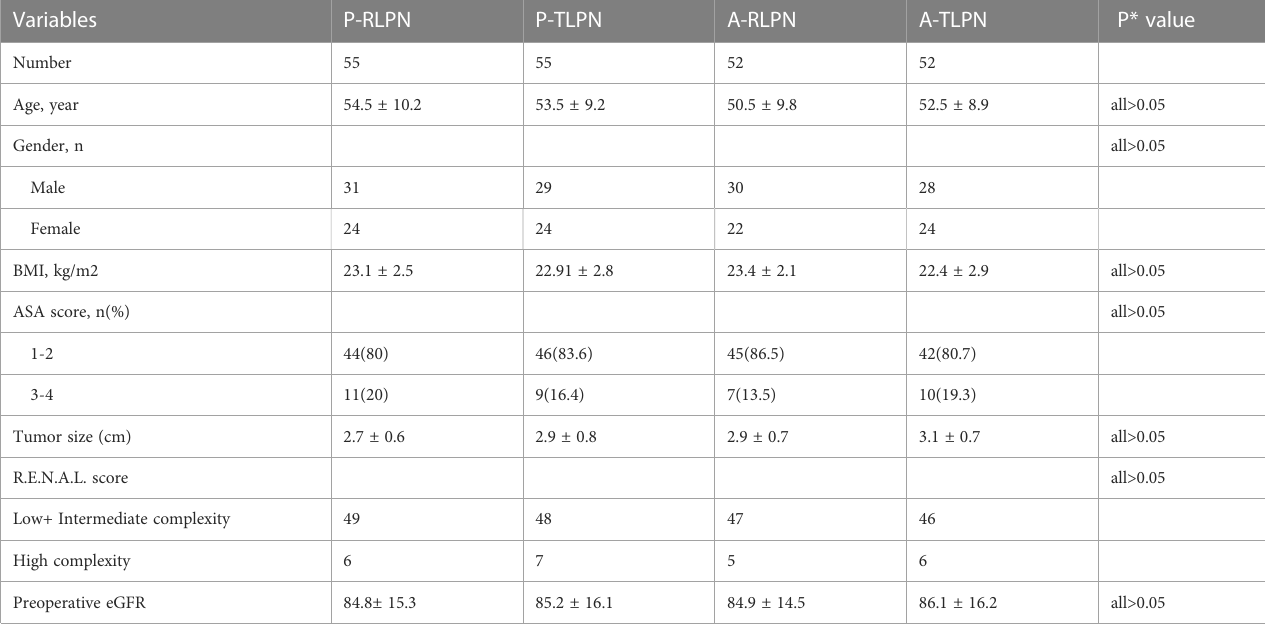
TABLE 1 Clinical baseline characteristics of